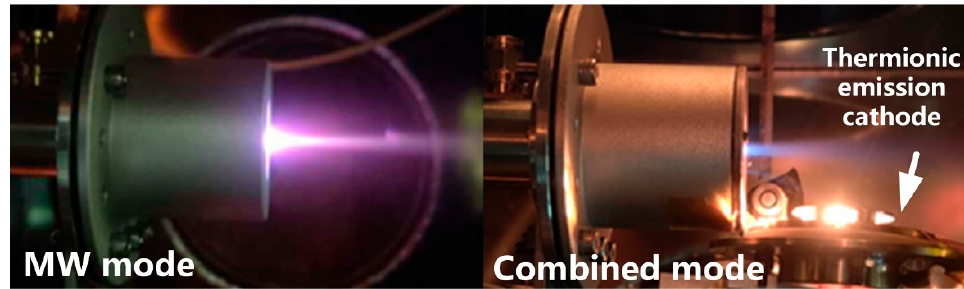
Figure 23. Microwave discharge mode and combined discharge mode of the MW coaxial resonant cusped field thruster.